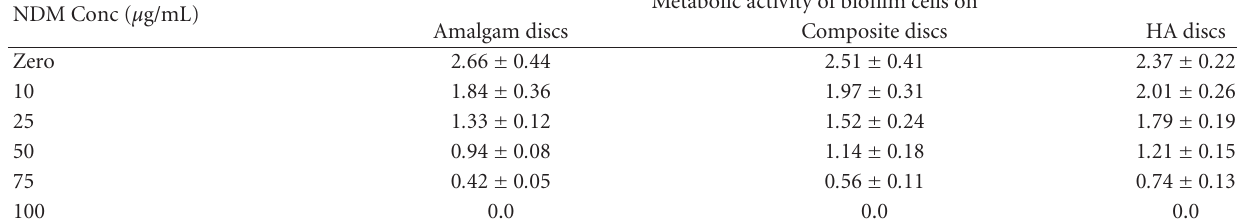
Table 3: Inhibition of S. gordonii metabolic activity measured by XTT assay in biofilm formed on dental restorative surfaces by NDM. NDM Conc ( µ g/mL)